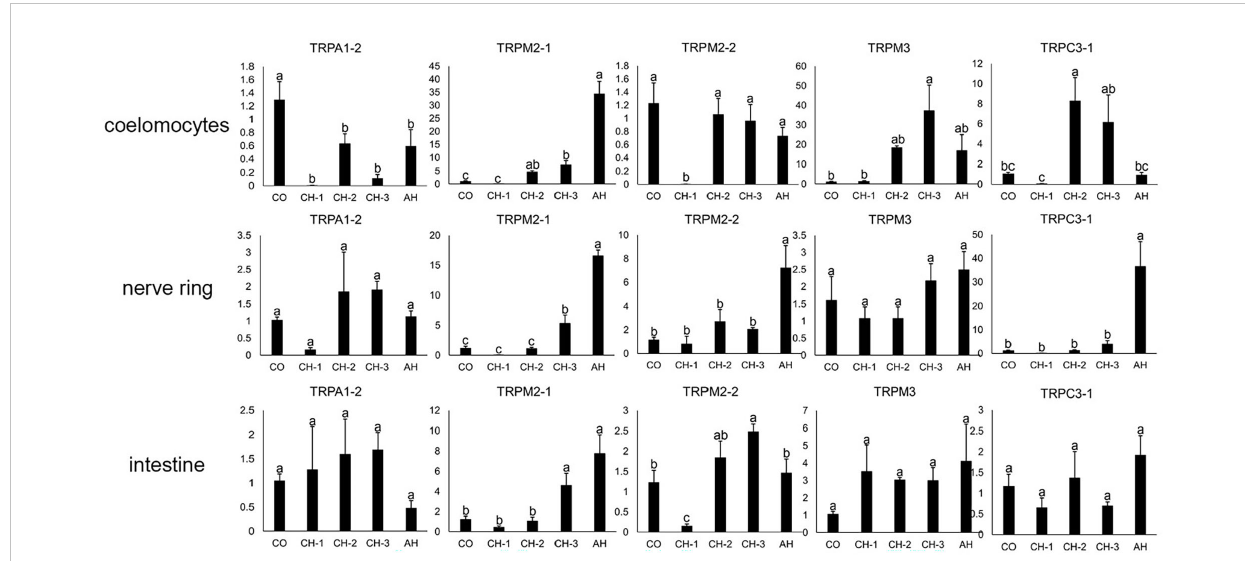
FIGURE 5 The relative expression level of TRPs in response to different temperature treatments. CO: control group, CH-1: chronic heat stress-1 group (temperature was 22°C), CH-2: chronic heat stress-2 group (maintained at 26°C for 1 day), CH-3: chronic heat stress-3 group (maintained at 26°C for 16 days), AH: acute heat stress group (temperature was raised with the rate of 2°C/h to 30°C for 48 hours). The relative expression levels as vertical coordinate. Data are presented as the mean ± S.E.M. (n = 5). b -actin and b -tubulin were selected as housekeeping genes. Signi fi cance testing used one-way ANOVA with Tukey ’ s Multiple Range Test and p <0.05 accepted as a signi fi cant difference. Signi fi cant differences are indicated on the bar with different lower-case